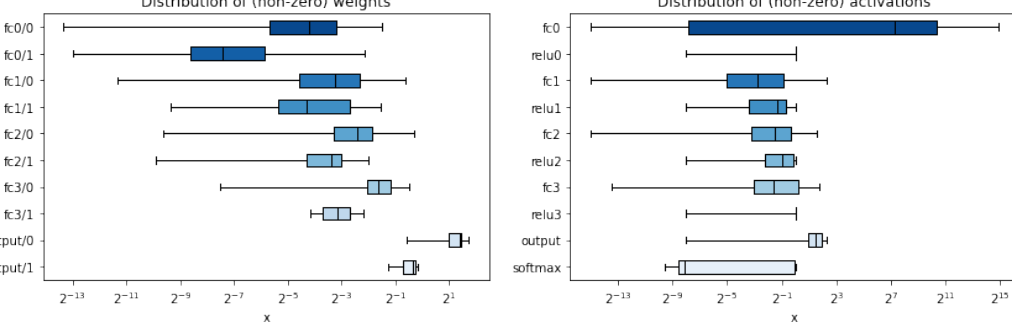
Figure 12. Distribution of weights and activations for each layer after model compression.